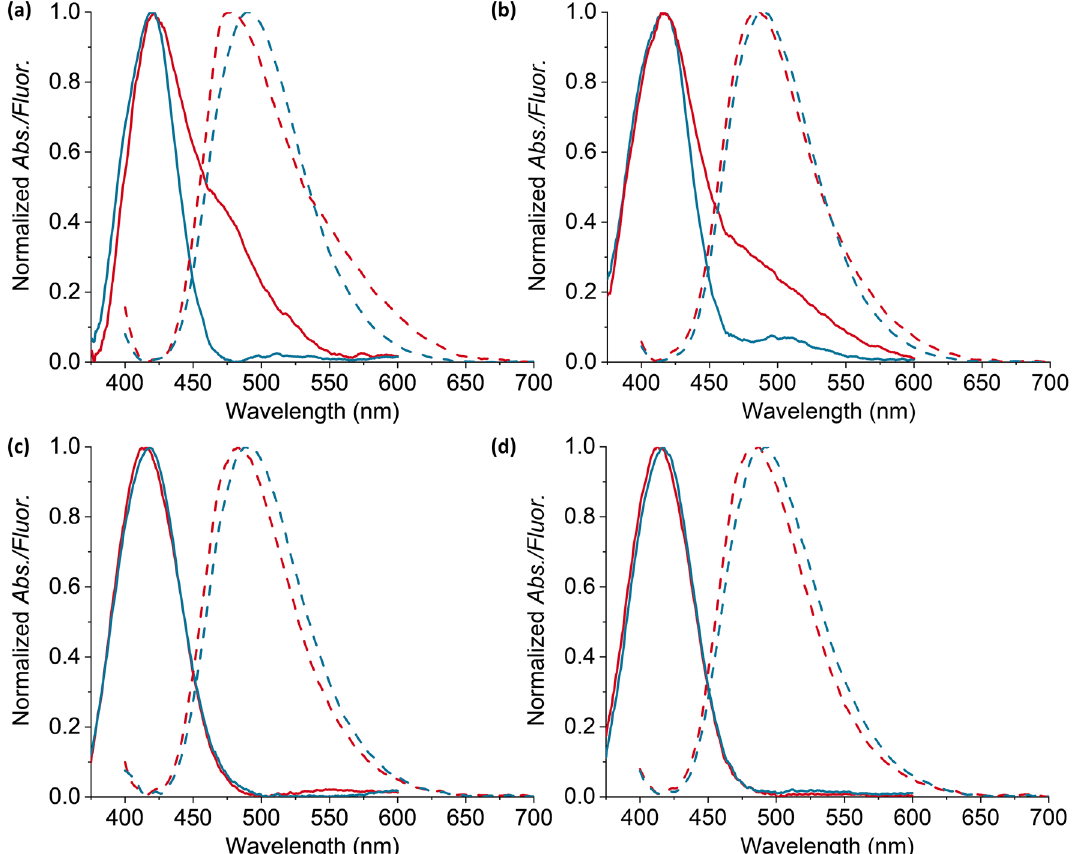
Figure 7. ( a ) Normalized absorption (solid lines) and fluorescence spectra (dotted lines) of MIPTBA@SiO 2 before (red line) and after (blue line) addition of 87 µM GPS-TBA in chloroform. ( b ) Normalized absorption (solid lines) and fluorescence spectra (dotted lines) of dNIPTBA@SiO 2 before (red line) and after (blue line) addition of 87 µM GPS-TBA in chloroform. The deprotonation bands are centered at 475 nm (absorption) and at 575 nm (fluorescence). ( c ) Normalized absorption (solid lines) and fluorescence spectra (dotted lines) of MIPTHA@SiO 2 before (red line) and after (blue line) addition of 74 µM GPS-THA in chloroform. ( d ) Normalized absorption (solid lines) and fluorescence spectra (dotted lines) of dNIPTHA@SiO 2 before (red line) and after (blue line) addition of 74 µM GPS-THA in chloroform. The deprotonation bands are absent in absorption and fluorescence spectra of MIPTHA@SiO 2 and dNIPTHA@SiO 2 . Fluorescence spectra were measured with λ ex = 385